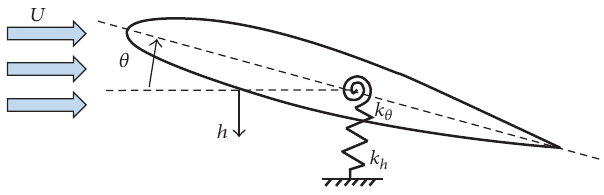
Figure 3: Schematic of an airfoil undergoing modal convergence